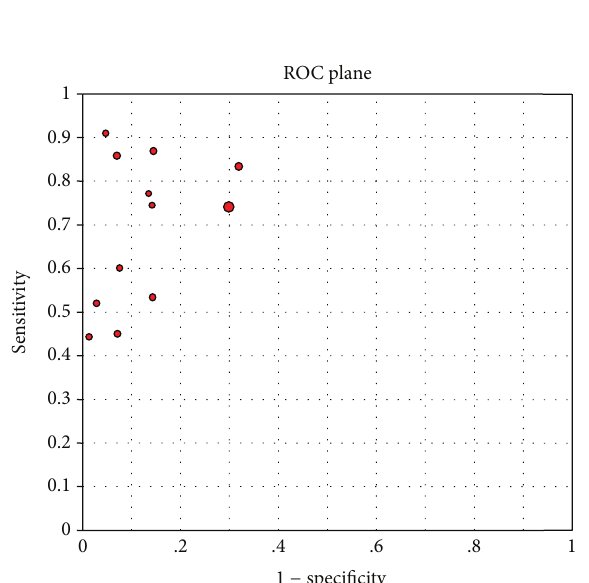
Figure 2: Deeks funnel plots.